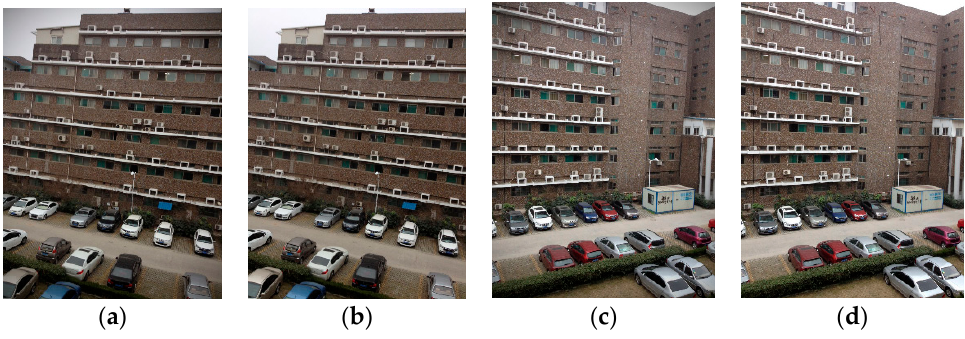
Figure 7. ( a , c ) Original images; ( b , d ) images with vignetting and photometrics corrected.